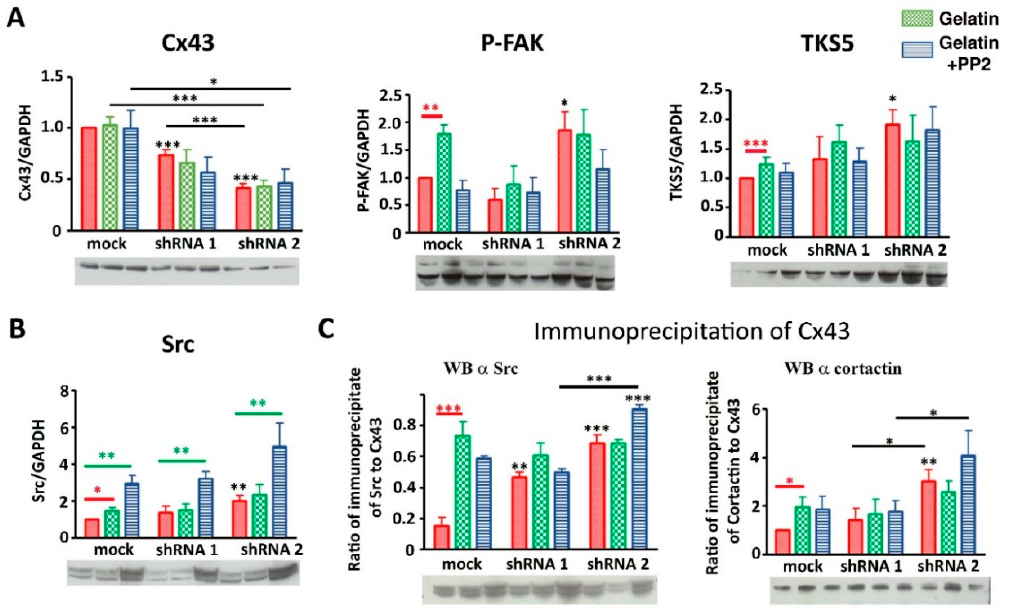
Figure 6. Protein (Cx43, P-FAK, TKS5 and Src) expressions and interactions in correlation with Cx43 expression. ( A ) Densitometric analysis of Cx43 (left), P-FAK (middle) and TKS5 (right) expression levels after normalization to GAPDH levels. ( B ) Densitometric analysis of Src protein expression level after normalization to GAPDH levels according to Cx43 expression level (N = 5). ( C ) Ratio of immunoprecipitation of Cx43 from U251 cells and immunoblotting of Src (middle) and cortactin (right) (N = 3). Red bar highlights di ff erences due to gelatin culture condition and black bar highlights di ff erences due to Cx43 expression diminution. Green bar highlights di ff erences due to PP2 exposition. * p < 0.05; ** p < 0.01 and *** p < 0.001. Values shown as mean ± SEM (see Supplementary Table